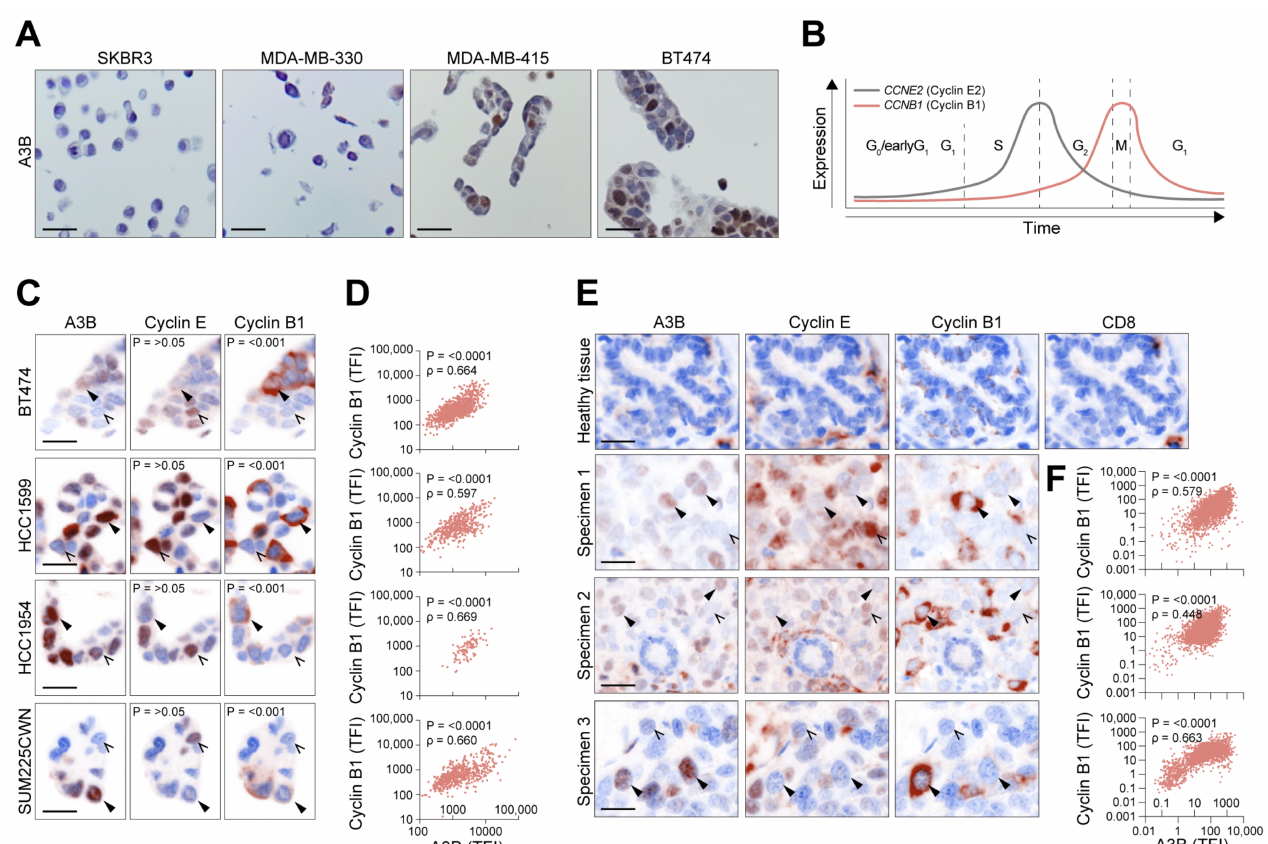
Figure 1. Protein expression of A3B in breast cancer is heterogeneous and correlates with cell cycle proteins. ( A ) Photomicrographs of A3B using conventional IHC on a diverse set of breast cancer cell lines, including the A3B-null (SKBR3), A3B-low (MDA-MB-330), and A3B-high (MDA-MB-415 and BT474) cell lines. Note the heterogeneous expression pattern of A3B in MDA-MB-415 and BT474. ( B ) General overview of the various cell cycle phases, overlaid with proteins known to peak during each respective phase. G 0 /G 1 is marked by low expression of both cyclins, while CCNE2 (Cyclin E2) expression rises throughout G 1 and into G 1 /S. Expression of CCNB1 (Cyclin B1) increases during G 2 and peaks at mitosis. ( C ) Photomicrographs showing the subcellular localization of A3B, Cyclin E2, and Cyclin B1 in various A3B-high breast cancer cell lines. Images acquired by multiplex IHC staining. Solid arrowheads indicate cells expressing A3B; open arrows point out cells negative for A3B. P- values are calculated by binomial testing, determining the probability of A3B being co-expressed with individual cell cycle markers. ( D ) Quantification of (subcellular specific) total fluorescent intensity (TFI) of individual cells as in ( C ), using Spearman correlation. ( E , F ) Healthy tissue and three primary breast cancer tumors stained for A3B, Cyclin E2, and Cyclin B1, using the same workflow and analysis presented in ( C , D ). CD8 staining of healthy tissue is included to account for the sporadic cytoplasmic staining encountered in isolated cells, attributable to A3G expressing tumor-resident leukocytes. Note that detection of A3B protein through regular and multiplex IHC requires separate optimization and antibody concentrations, accounting for the slight difference in staining pattern between these two procedures. Scale bars denote 20 µ m. TFI: total fluorescent